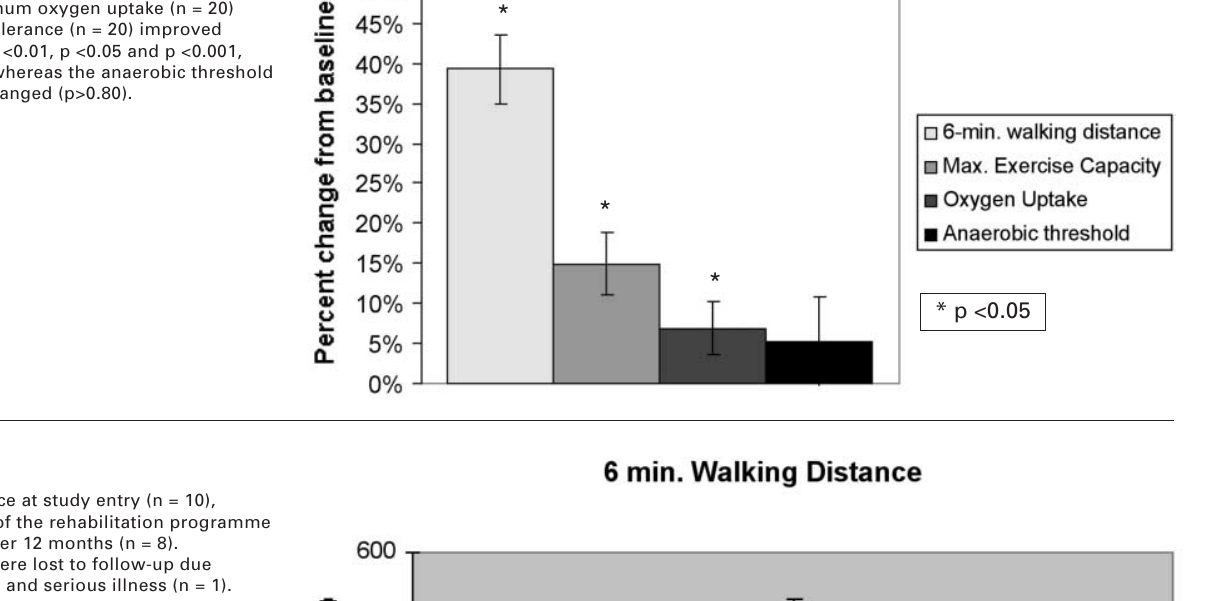
COPD and asthma patients were analysed as one group. When analysis was done for each group separately, the improvement in walking distance and exercise capacity remained significant.